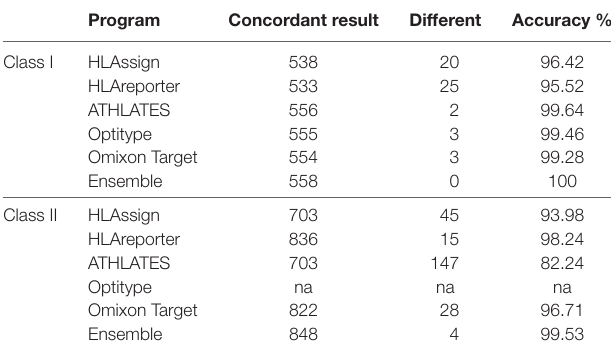
TaBle 1 | Summary of accuracies of the HLA interpretation programs and the ensemble result based on Finnish Red Cross Blood Service dataset comprising 93